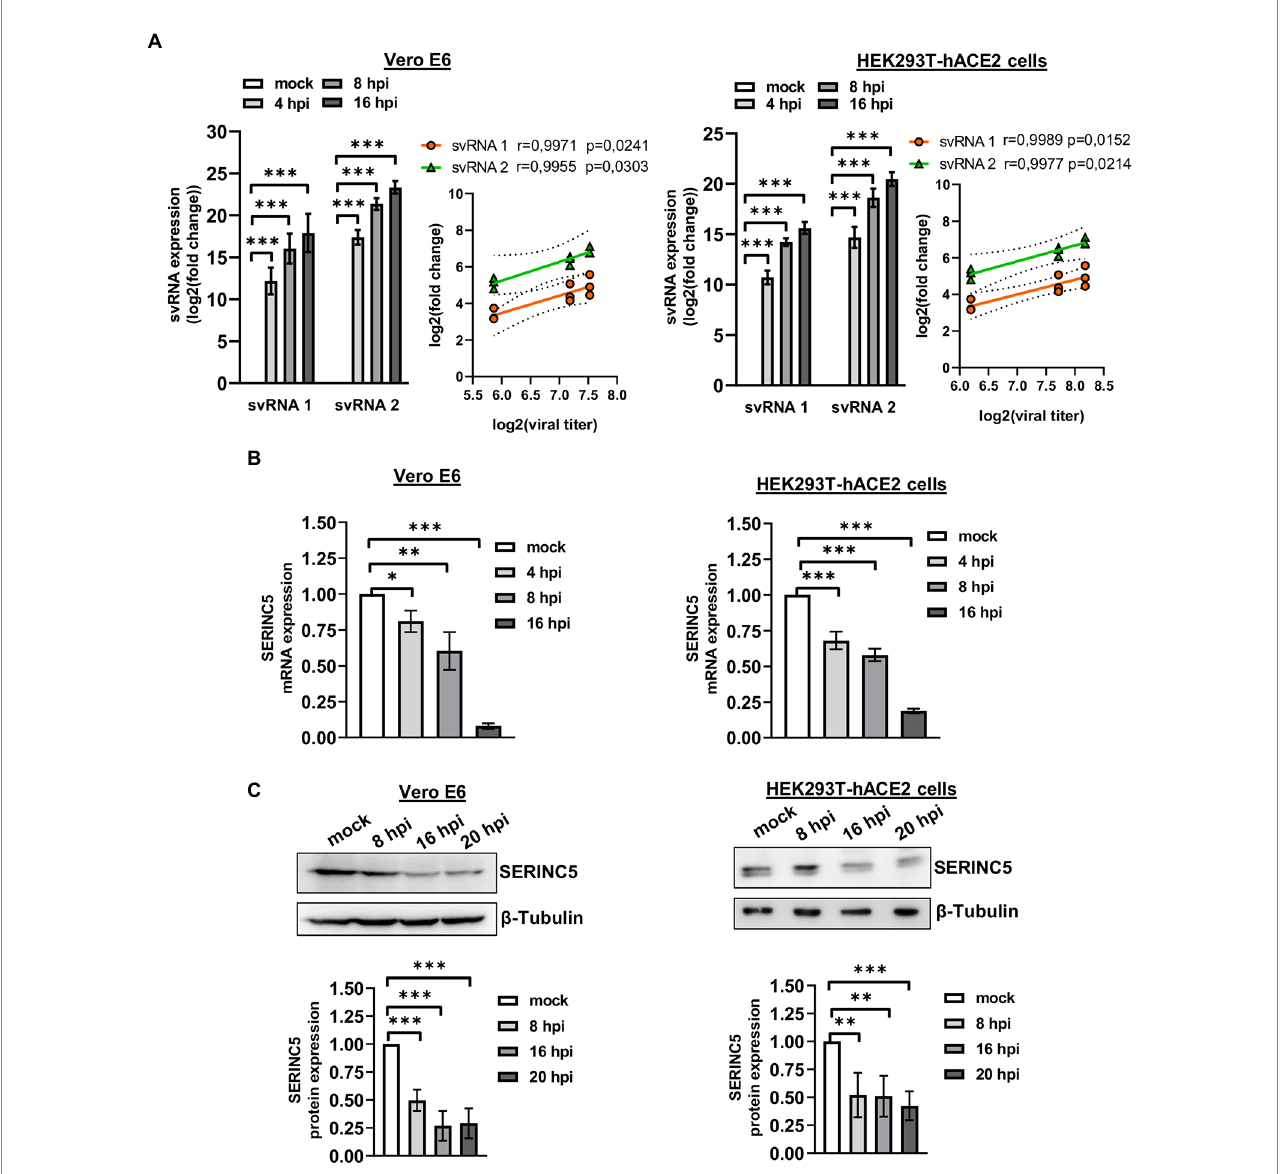
FIGURE 4 Analysis of the expression of svRNAs 1 and 2 and SERINC5 in Vero E6 and HEK293T-hACE2 infected cells. (A) RT-qPCR analysis of svRNAs 1 and 2 expression and correlation analysis between log2 fold changes obtained for svRNA 1 and svRNA 2 and log 2 viral titers in SARS-CoV-2-infected (MOI, 1 PFU/ cell) Vero E6 (left panels) and HEK293T-hACE2 (right panels) cells at 4, 8, and 16 hpi. The ΔΔ Ct method was used for relative quantification, with U6 snRNA as an endogenous control. Data are represented as log2 fold change with respect to mock values and are the mean ± SD of at least three